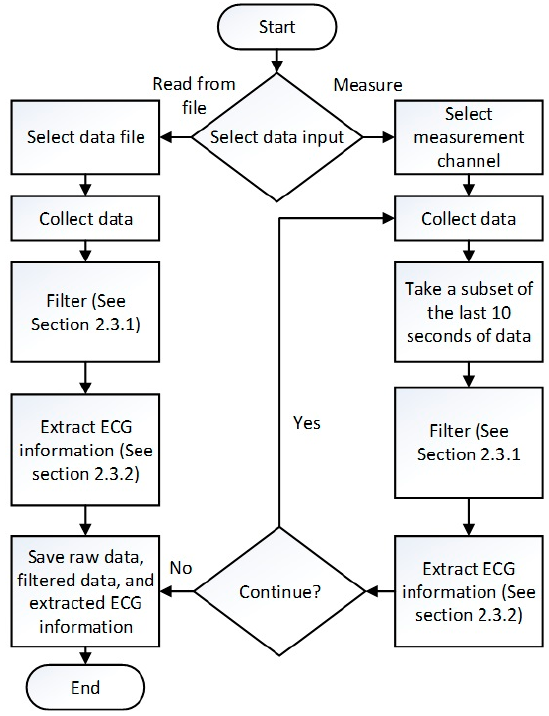
Figure 4. LabVIEW program flowchart.